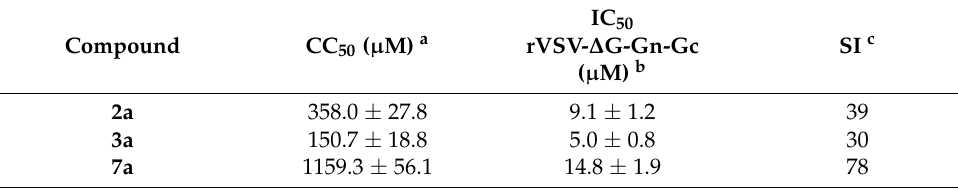
Table 5. Antiviral activity of the compounds 2a , 3a , and 7a against rVSV- ∆ G-Gn-Gc.